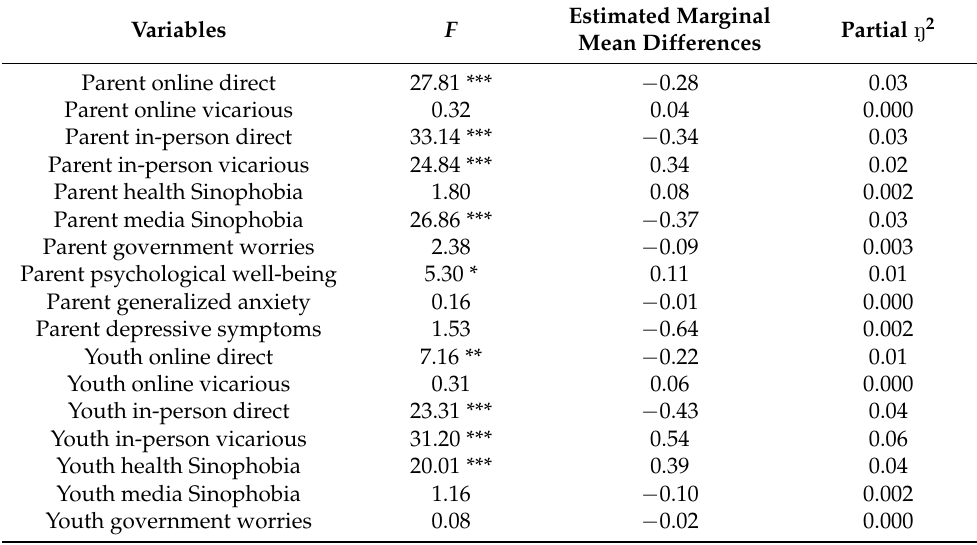
Table 3. Comparisons of parents’ and youth’s discrimination, Sinophobia perceptions, government- related worries, and mental health indices between 2020 and 2021 from ANCOVA